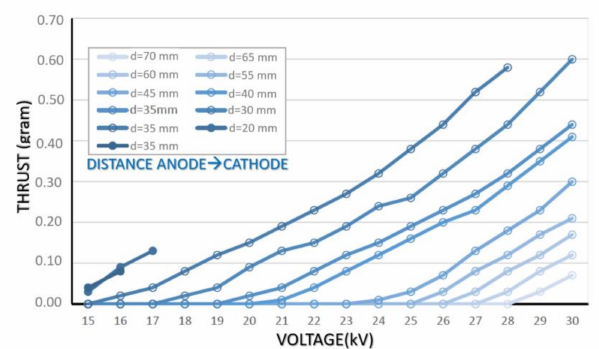
Figure 12. Single thruster: thrust vs. voltage for difference distances between cathode and anode.